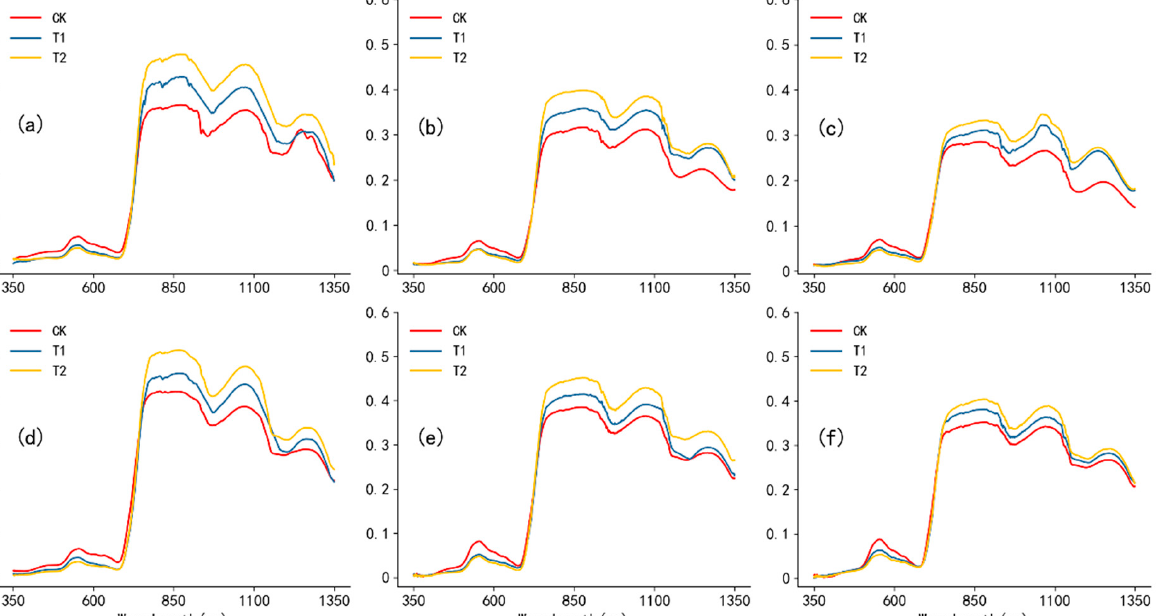
Table 4. The LAI values of rice under different treatments at different periods after heading, in 2016–